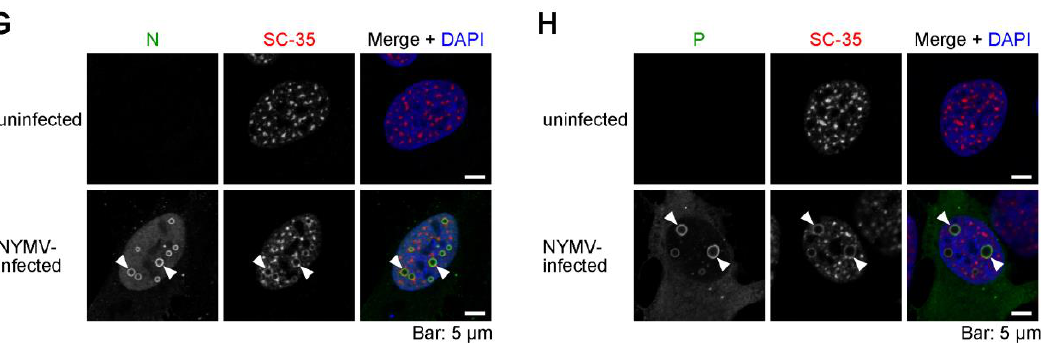
Figure 4. The relationship between viral IB-like structures of NYMV and the nuclear biomolecular condensates. ( A – D ) N alone, P alone, or both N and P were expressed in uninfected U-2 OS cells, and their co-localizations with nucleoli recognized by an anti-B23 antibody ( A , B ) or nuclear speckles recognized by an anti-SC-35 antibody ( C , D ) were examined. Arrowheads indicate abnormal nucleoli co-localized with viral condensates in ( A , B ). Arrowheads and arrows indicate nuclear speckle co-localized with viral condensates and puncta, respectively in ( C , D ). ( E – H ) The co-localizations of N and P with nucleoli ( E , F ) or nuclear speckles ( G , H ) in NYMV-infected U-2 OS cells were examined. Arrowheads indicate nuclear speckles co-localized with IBs in ( G , H ). The presented confocal microscopic images were the images of single focal